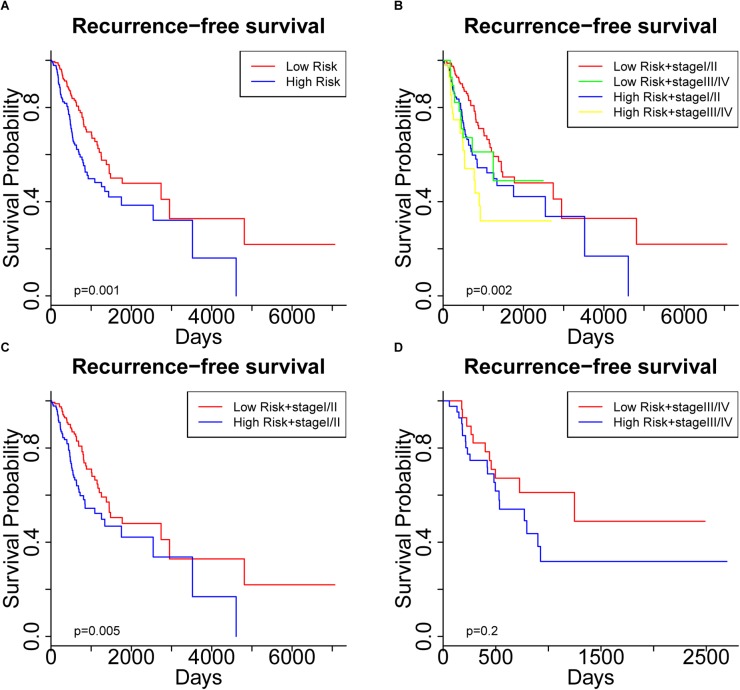
Kaplan Meier curve showing recurrence-free survival (RFS) of the patient cohort grouped by (A) prognostic score (PS), and (B) PS plus pathological stage. RFS of the patients stratified by PS in subgroups with (C) early-stage tumors and (D) advanced-stage tumors.